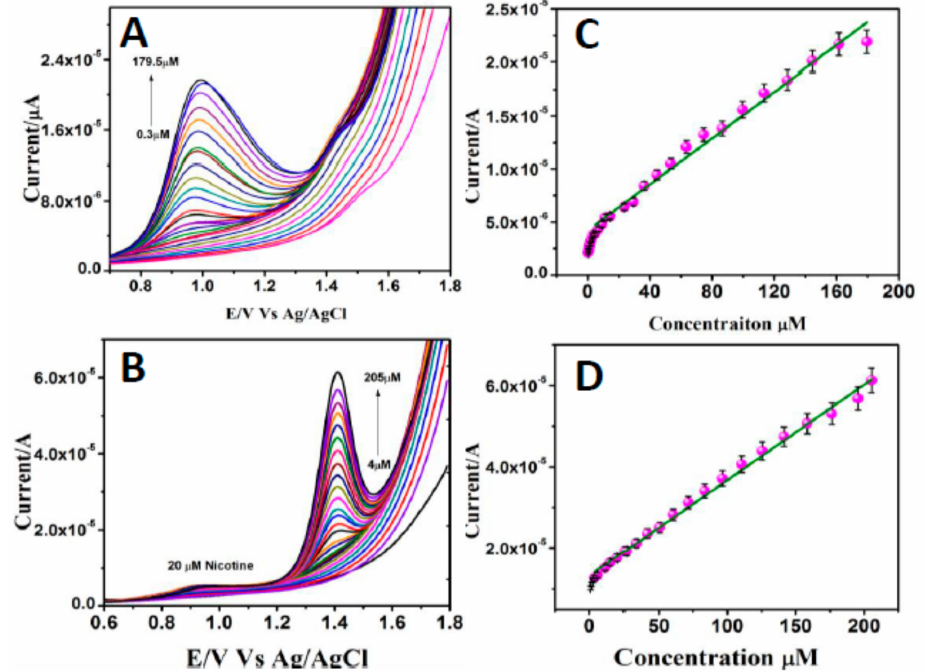
Figure 8. SWVs obtained for the various concentrations of ( A ) nicotine (0.3-179.5 µ M) in the presence of 75 µ M of ca ff eine and ( B ) ca ff eine (4-205 µ M) in the presence of 20 µ M of nicotine in 0.1 M PBS (pH 7.0) at HA-GN-MWCNT / GCE. In ( C ) and ( D ) are shown the corresponding calibration